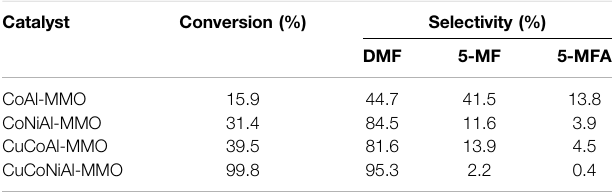
TABLE 2 | Performance comparison of different catalysts for the selective hydrogenolysis of HMF. Catalyst